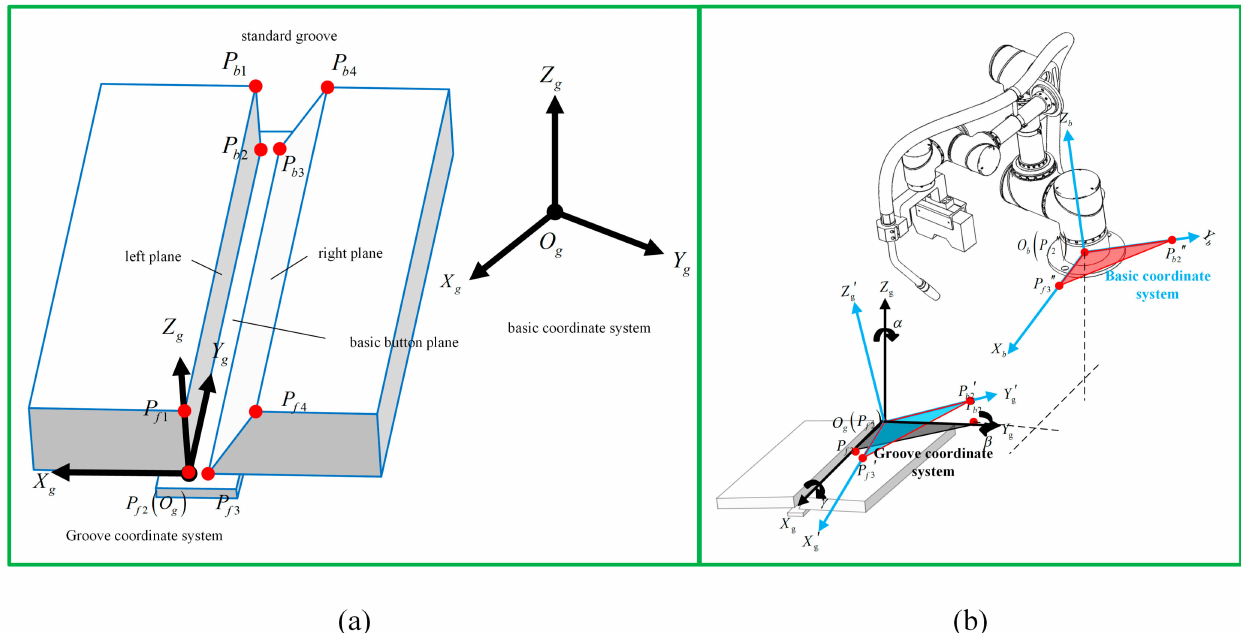
Figure 5. ( a ) The groove model and characteristic points are represented in the groove co-ordinate system. ( b ) Transformation relationship between the groove co-ordinate system and the basic co- ordinate